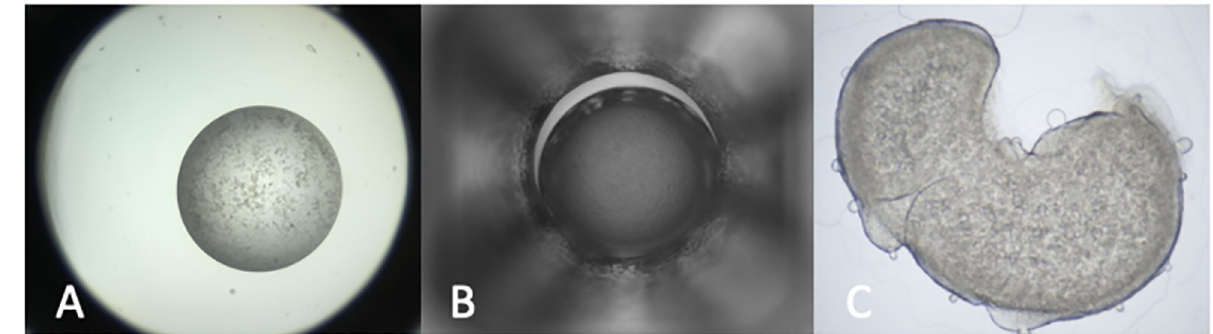
Fig 3. Different experimental setups found in the MARCO training set. Images of three different crystallisation trial types are included in the MARCO dataset image A: Vapor Diffusion (the most abundant), images of these experiments were contributed by GSK, MERCK, C3 and BMS. B: Microbatch under oil. Most of the images from this type of experiment were from the HWI, with a small number from GSK. C. LCP bolus—there are few of these in the dataset, and were provided by MERCK.